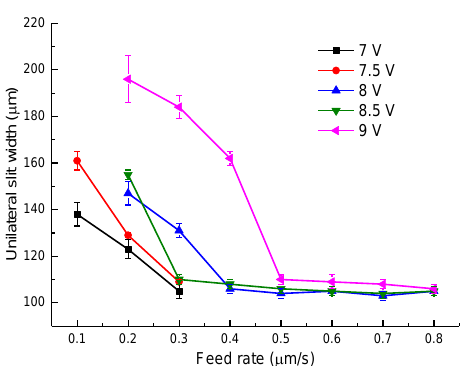
Figure 9. The variation of unilateral slit width with electrode feed rate, utilizing an electrode measuring 0.2 mm in diameter.